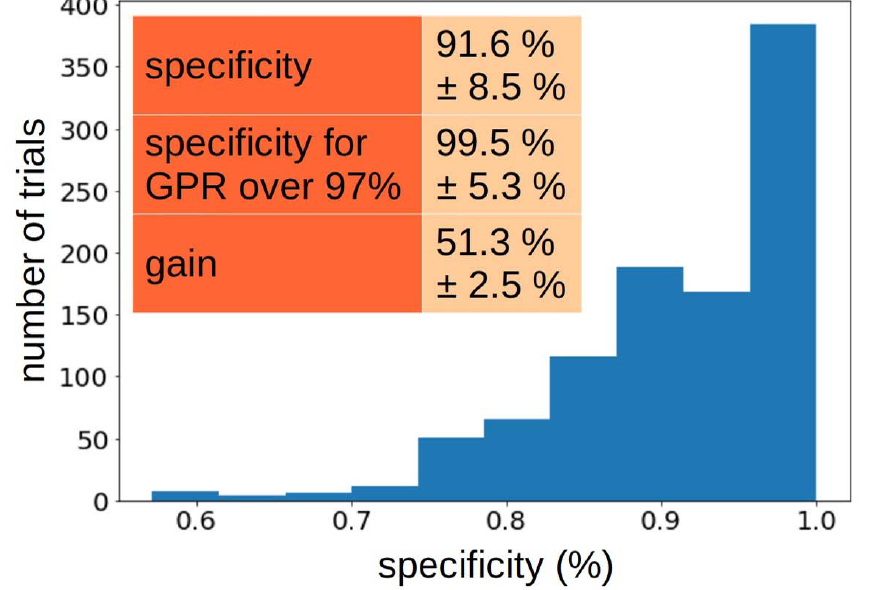
Figure 2. Histogram of the algorithm specificity in subsequent 1000 draws of data split into training and test sets. The average values of the prediction specificity of the GPR values for the tested 98% threshold, the average specificity for the 97% threshold, and the average time gain achievable with the proposed algorithm are